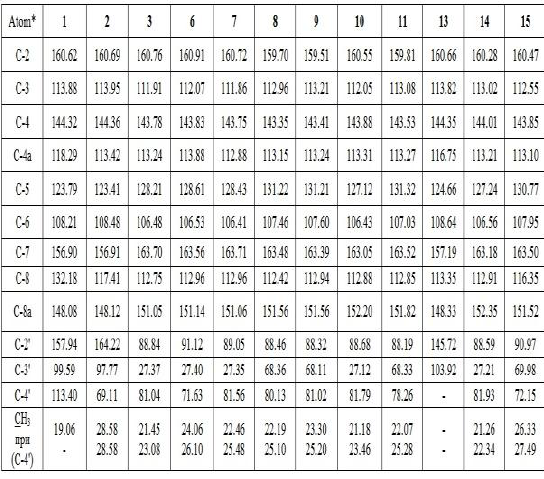
* Used numeration of coumarin sceleton’s atoms like in structure ( 3 ) (scheme 1). Note: *For